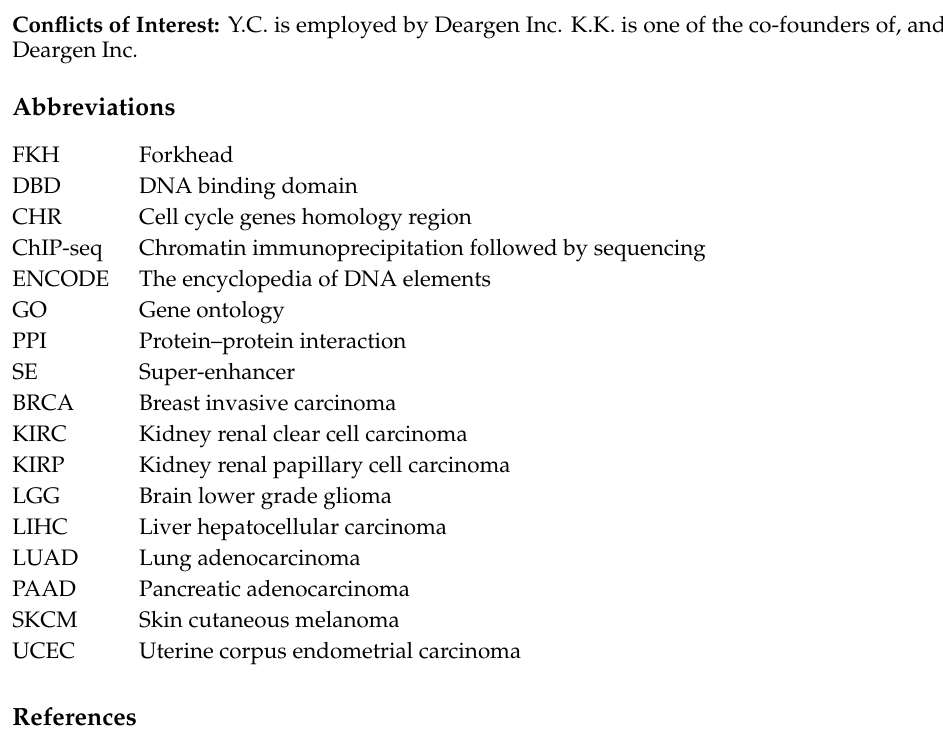
6141 / s1. Table S1: List of ChIP-seq data used in this study, Table S2: FOXM1 binding sites identified in Table S4: FOXM1 peak clusters (C1-C6), Table S5: FOXM1 binding sites associated with super-enhancers, Figure S1: Functional predictions of FOXM1 binding sites, Figure S2: Correlation of expression levels of the FOXM1 and NFY subunit-encoded (NFYA, NFYB, or NFYC)